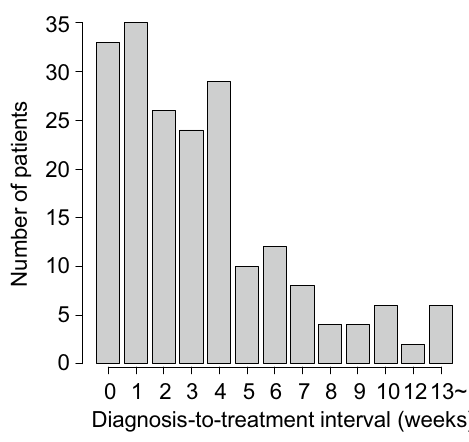
Figure 1. Distributions of diagnosis-to-treatment